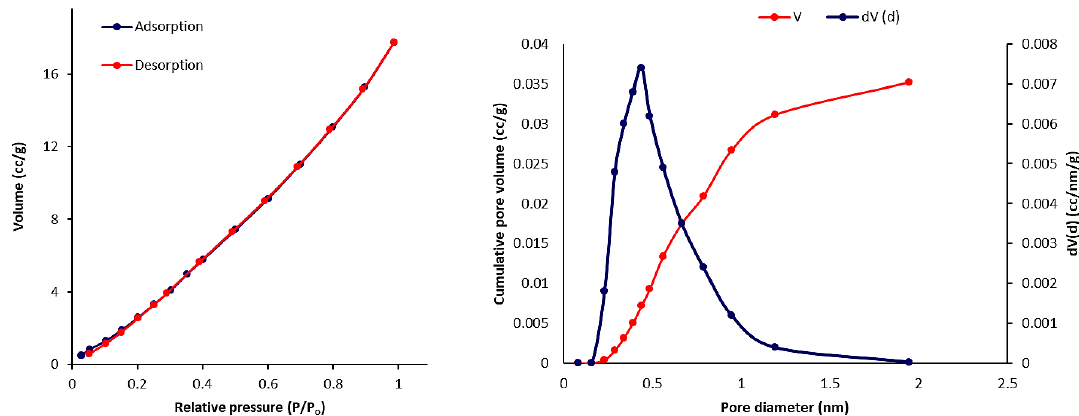
Figure 3. Adsorption–desorption isotherms of N 2 and pore size distribution curve for 4 .